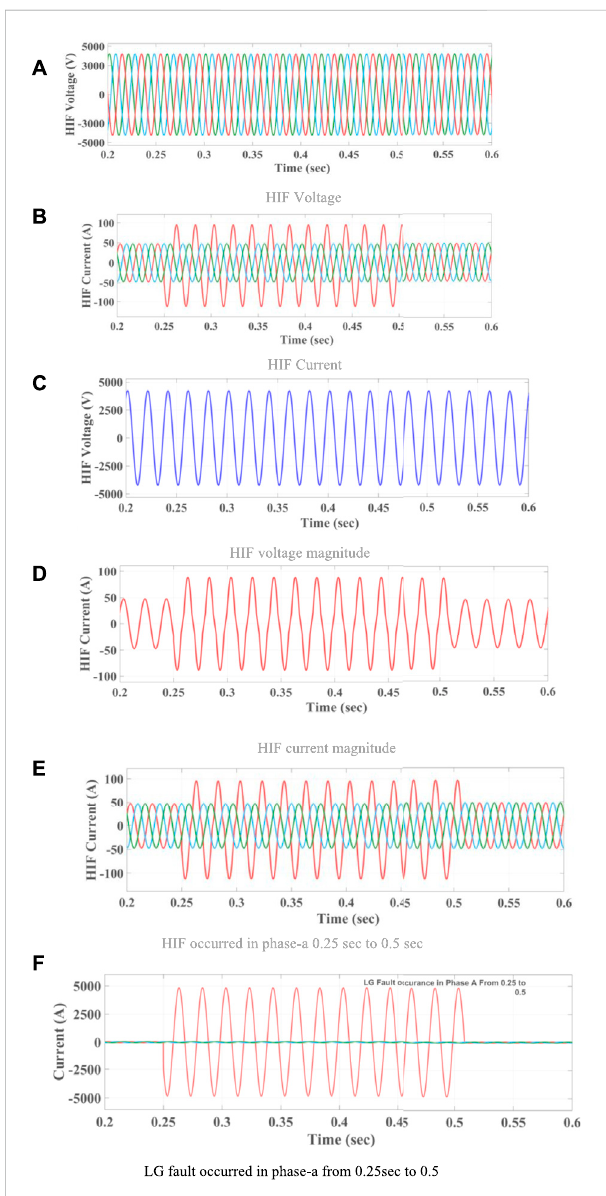
FIGURE 14 The three-phase current waveform observed for the period of 0.25 – 0.5 s in case of HIF fault and single line to ground (LG). (A) HIF Voltage (B) HIF Current (C) HIF voltage magnitude (D) HIF